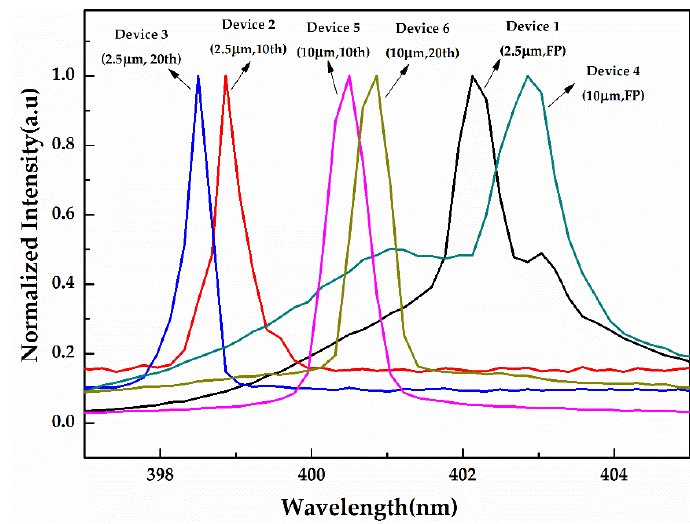
Figure 5. Emission spectrograms of fabricated laser diodes (Devices 1–6) driven by electrical impulses with a 500 ns pulse width and a 1 kHz repetition rate.